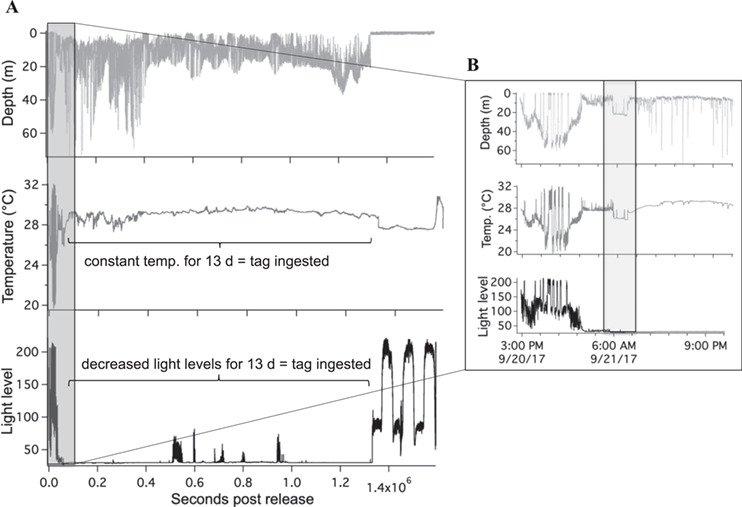
Example of tag data from delayed mortality (LA22) demonstrating full archive (A) and zoomed in plot of the first 14 h (B)